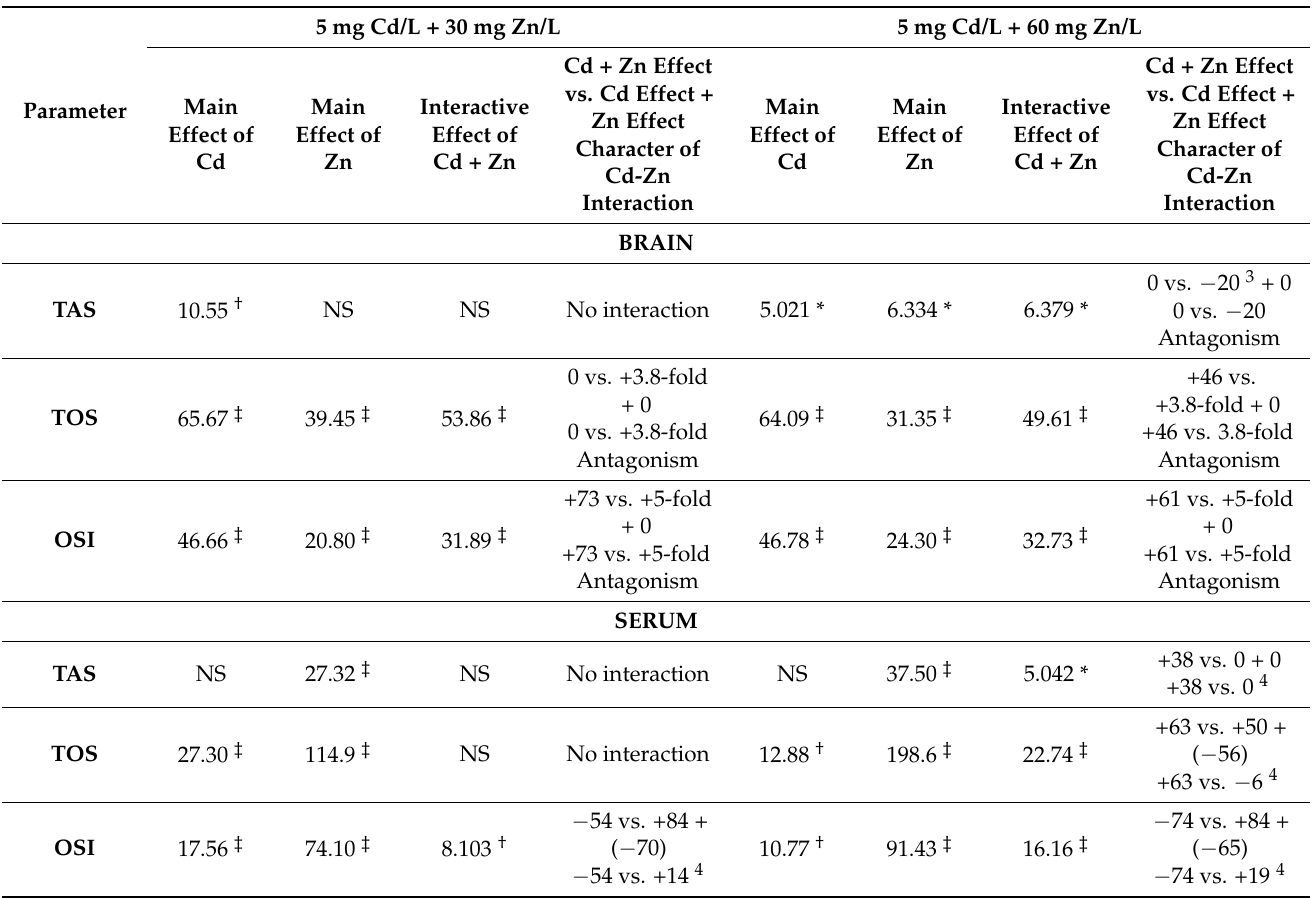
Table 5. Interactive and main effects of cadmium (Cd) and zinc (Zn) on total antioxidative status (TAS), total oxidative status (TOS), and oxidative stress index (OSI) in the brain tissue and serum of male rats 1,2 .